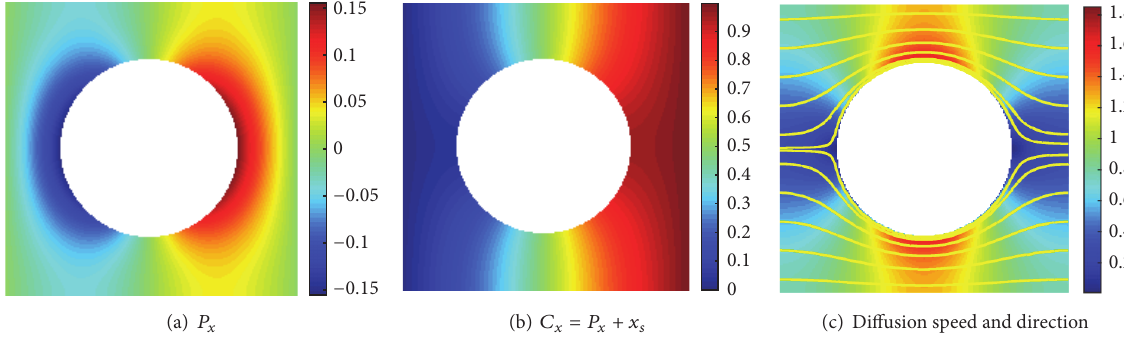
Figure 5: Fields for a unit cell of 𝜙 = 0.71 , comprised of a solid circle: (a) solution to the homogenized problem, (b) concentration field transformed from 𝑃 𝑘 , and (c) magnitude of concentration gradient √(∇ 𝑥 𝐶 𝑥 ) 2 + (∇ 𝑦 𝐶 𝑥 ) 2 (diffusion speed) and direction. The fields with respect to 𝑦 are the same as shown above but rotated by 90 degrees.